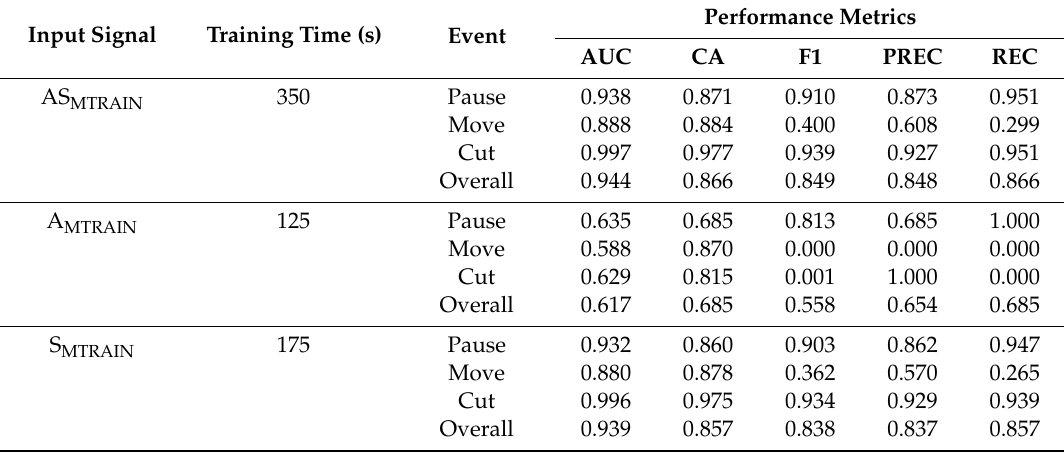
Table 3. Results of classification performance metrics following the training of the artificial neural network (ANN); area under the curve (AUC); classification accuracy (CA); Pause events. Precision (PREC); recall (REC); (F1) the harmonic mean of PREC and